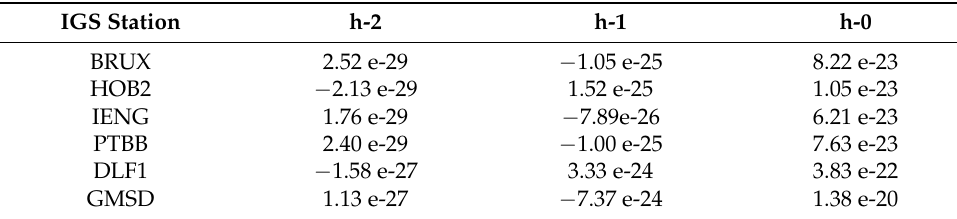
Table 3. The noise coefficients of the external clock connected with IGS